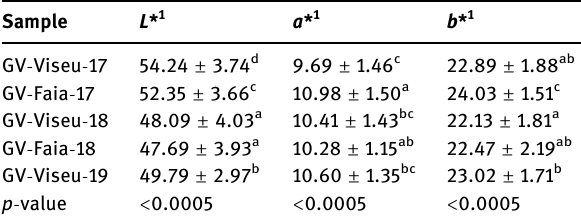
Table 6: Colour coordinates in the hilum ( mean ± standard